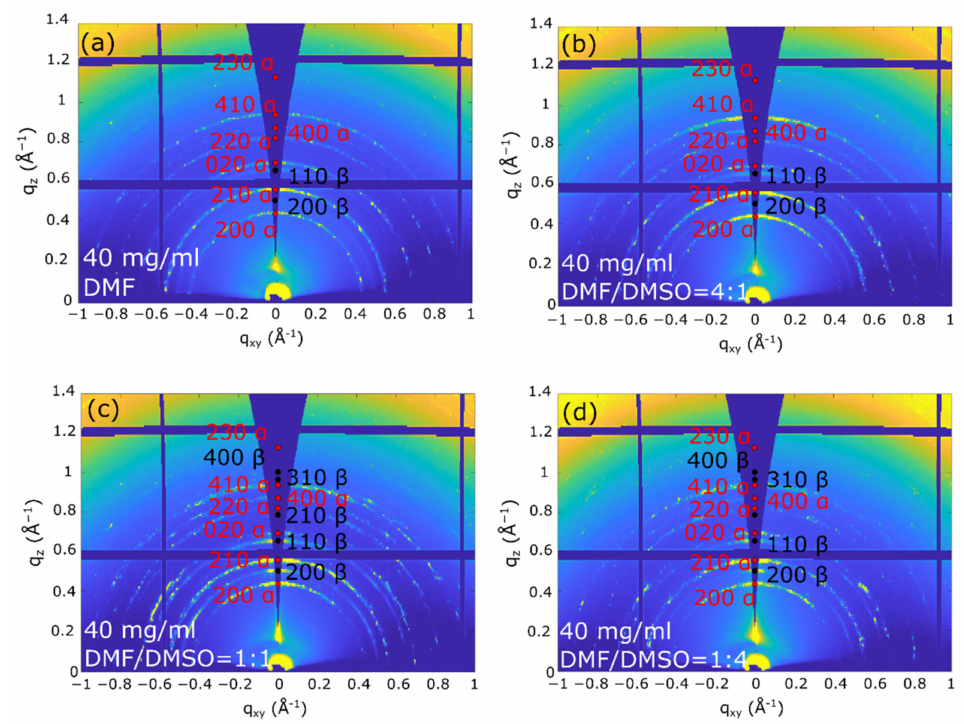
Figure 4. 2D-GIXD images taken at 0.2 ◦ on the (PRSH)PbI 3 films prepared with different DMF/DMSO solvent fractions: DMF ( a ), DMF/DMSO = 4:1 ( b ), 1:1 ( c ), and 1:4 ( d ). The reflection indices of the α and β phases and the corresponding q positions are indicated in red and black,